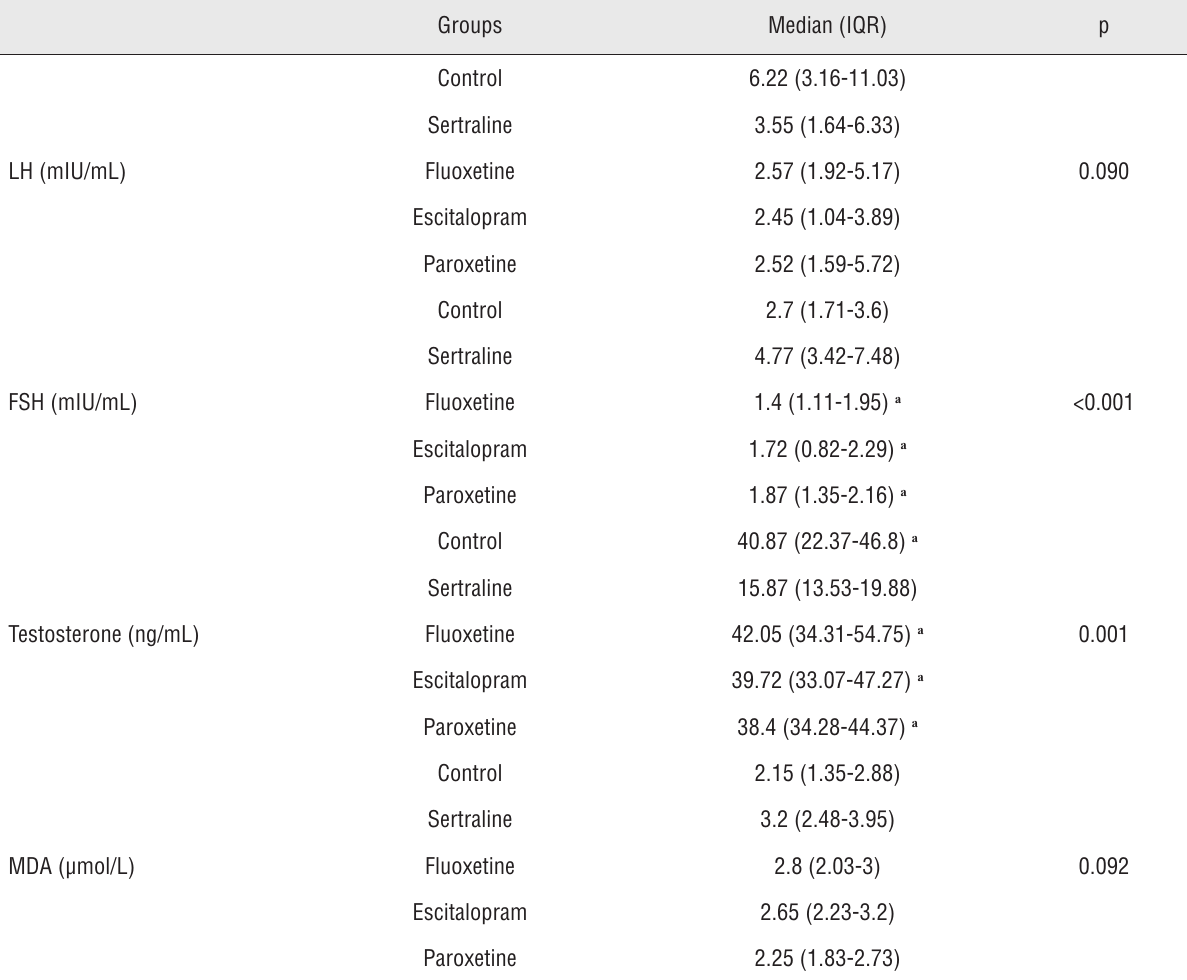
Table 3 - The Serum hormones and MDA levels of all groups and statistical comparisons.